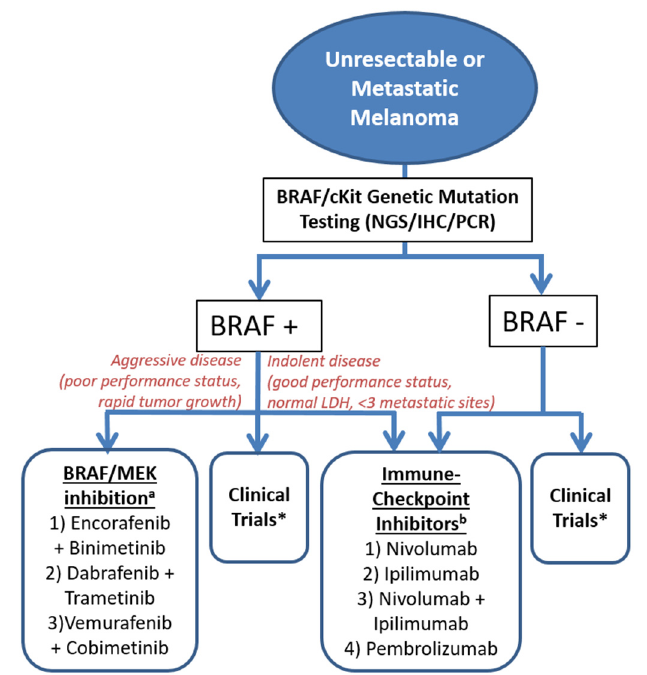
Figure 2. Systemic treatment options for unresectable or metastatic melanoma. Abbreviations : BRAF positive for mutation (BRAF + ), BRAF negative for mutant type (BRAF − ), immunohistochemistry (IHC), lactate dehydrogenase serum level (LDH), mitogen-activated protein kinase (MEK), next-generation sequencing (NGS), polymerase chain reaction (PCR). * Areas under active investigation include, but are not limited to di ff erent immunotherapy and BRAF / MEK inhibition regimens, or c-kit targeted therapies. a FDA-approved for advanced melanoma with BRAF V600E or V600K mutation.